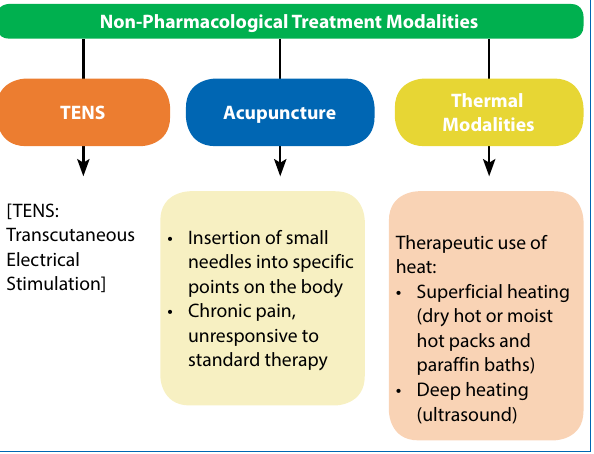
Figure 7: Treatment of muscle pain in sports injuries